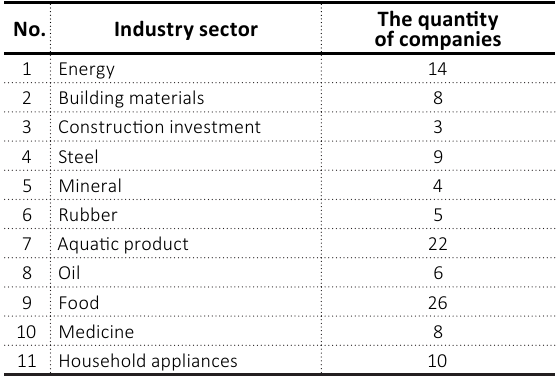
Table 2. Sample used in the